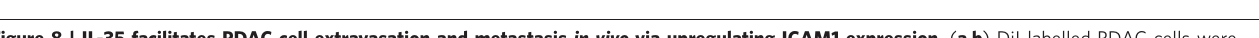
options; scale bar, 100 m m ( a ) and 50 m m ( d